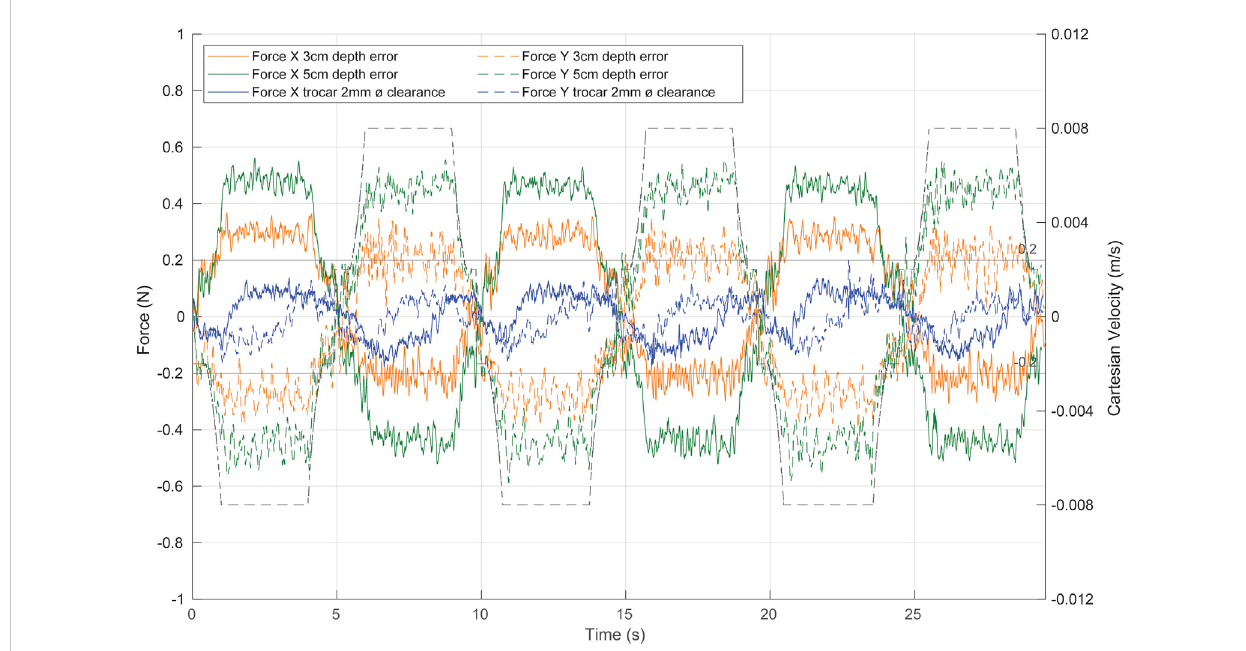
FIGURE 12 System response to repetitive linear movement of the TCP in different uncertainty scenarios. Green, with a fulcrum height error of 5 cm; orange, with a fulcrum height error of 3 cm; blue, with a trocar clearance of 2 mm. The dashed black line represents the TCP Cartesian